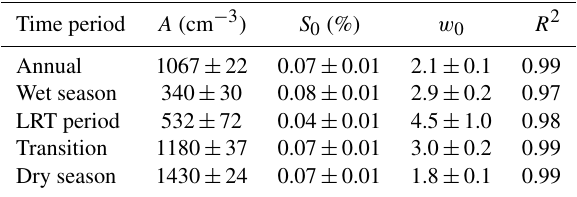
Table 6. Erf fit parameters describing CCN spectra N CCN ( S ) vs. S as parametrization input data (compare to Figs. 10 and 11b, d). Fit parameters are provided for annually averaged CCN spectra and resolved by